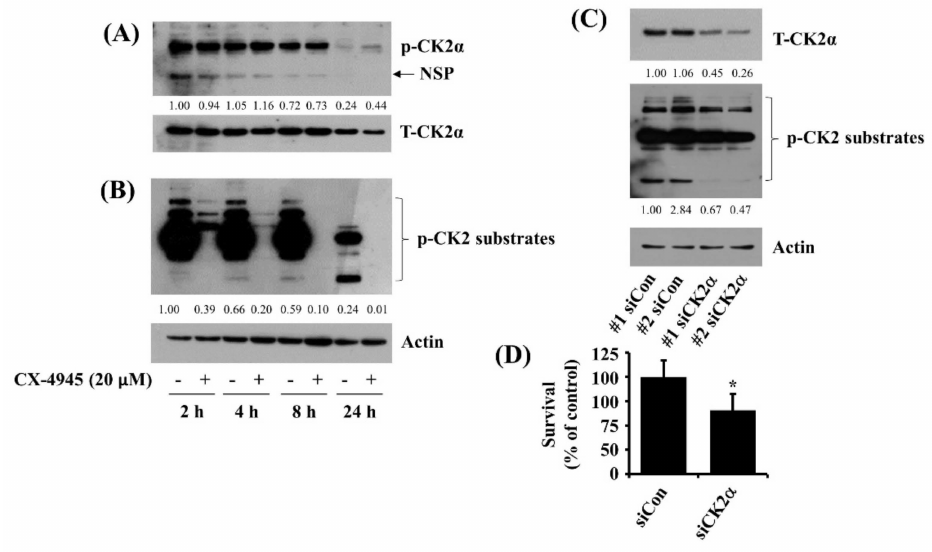
Figure 3. Effect of CX-4945 on phosphorylation and expression levels of CK2 α and CK2 substrates in HuCCT-1 cells. ( A , B ) HuCCT-1 cells were treated with CX-4945(20 µ M) or vehicle control (DMSO) for the time designated. At each time point, whole-cell lysates were prepared and analyzed for levels of p-CK2 α , T-CK2 α , p-CK2 substrates, or β -actin by Western Blotting. ( C ) HuCCT-1 cells were transfected with 200 pM of control siRNA(siCon) or CK2 α siRNA (siCK2 α ) for 48 h. Whole-cell lysates were prepared and analyzed for T-CK2 α , p-CK2 substrates, or β -actin by Western Blotting. ( D ) HuCCT-1 cells were transfected with 200 pM of control siRNA (siCon) or CK2 α siRNA (siCK2 α ) for 48 h, then measured the number of surviving cells by cell count assay. The cell count assay was performed in triplicate. Data are means ± SE of three independent experiments. * p < 0.05 compared to the value of siCon or siCK2 α at the indicated